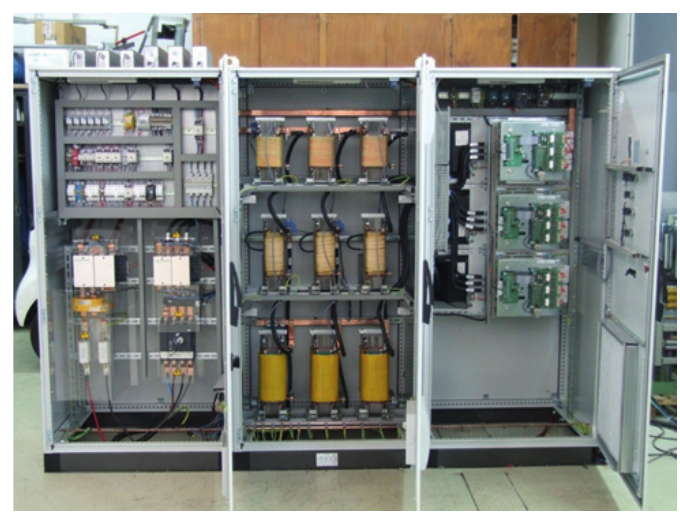
Figure 18. Four-wire 90-kVA VC-VSI inverter.